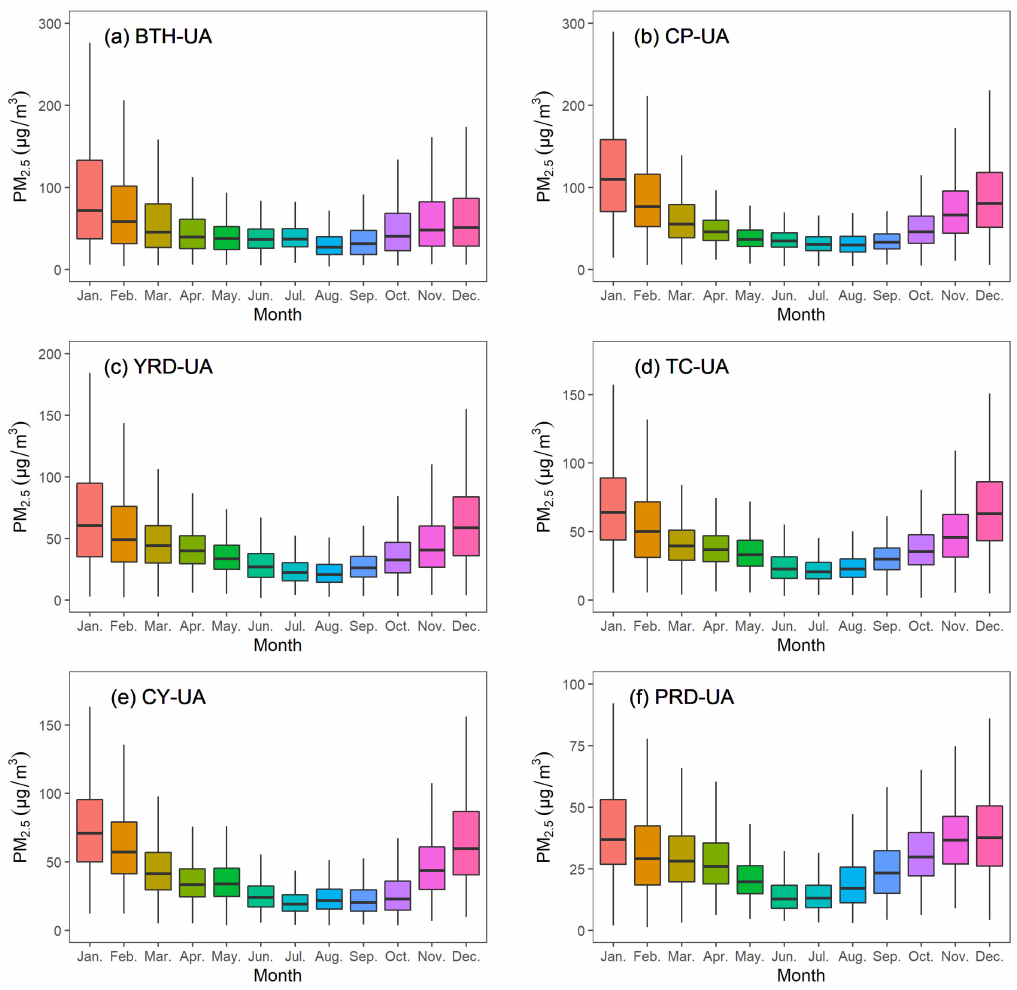
Figure 3. Monthly average mass concentration of PM 2.5 in six urban agglomerations of China over the period of 2017–2020. Shown are the median (central horizontal bar within the boxes), 25th and 75th percentiles (lower and upper bars of the boxes, respectively), and minimum and maximum (lower and upper whiskers, respectively). ( a ) BTH-UA, ( b ) CP-UA, ( c ) YRD-UA, ( d ) TC-UA, ( e ) CY-UA and ( f )